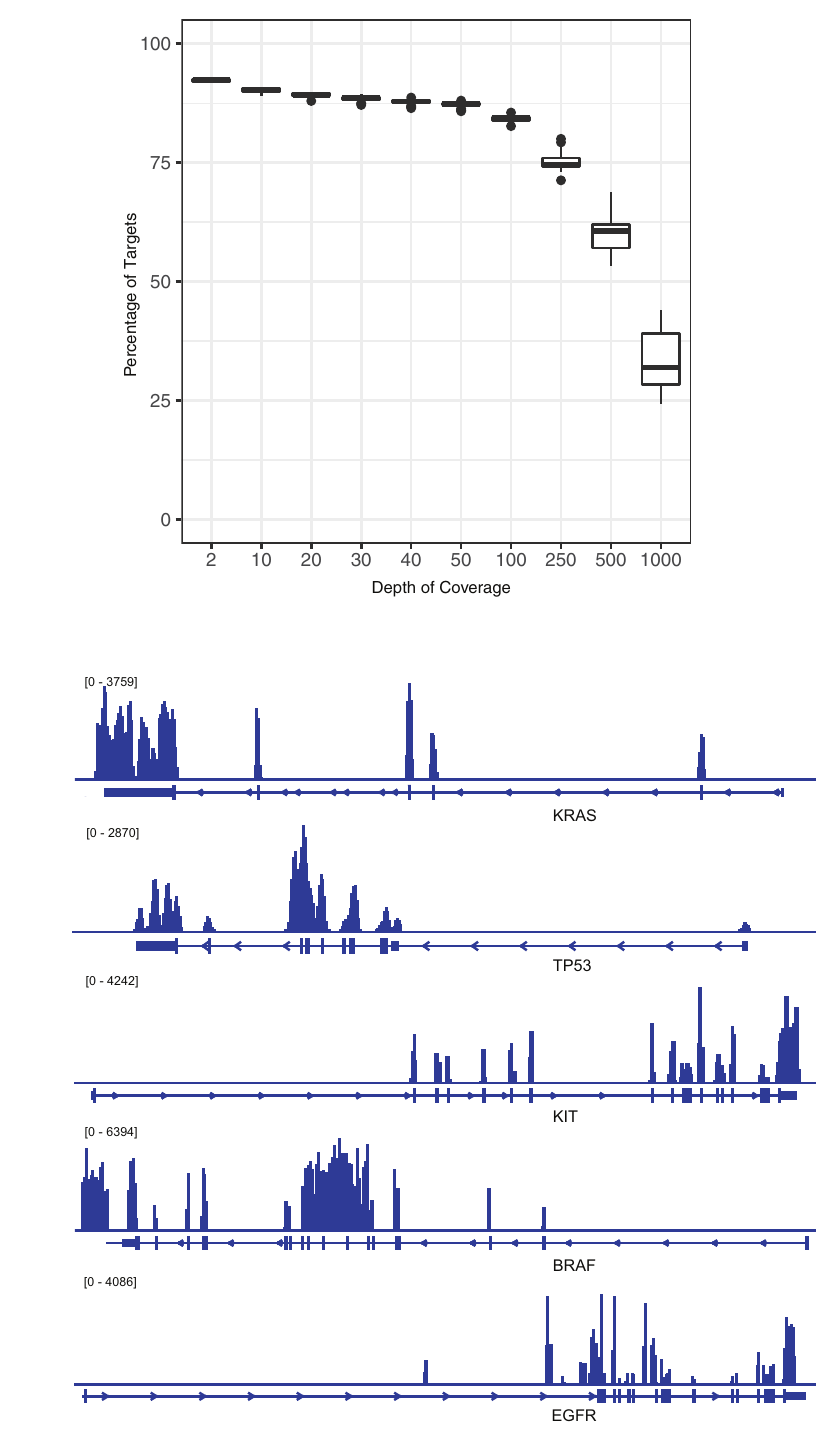
Fig 1. Coverage of ActSeq next-generation sequencing panel. A) Depth of coverage and corresponding percentage of target regions as observed in pilot runs. B) Coverage profile on selected cancer genes in HD827 data as extracted with